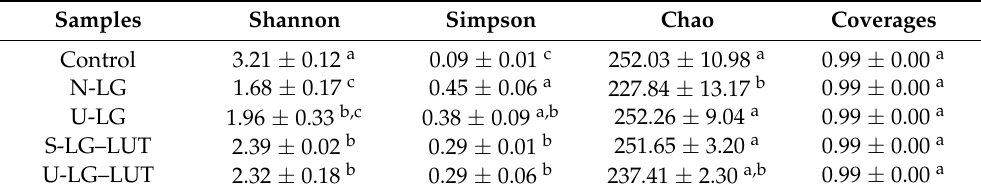
Table 2. Intestinal microbiota index table ( p < 0.05). Letters (a–c) in the table mean significantly different ( p <